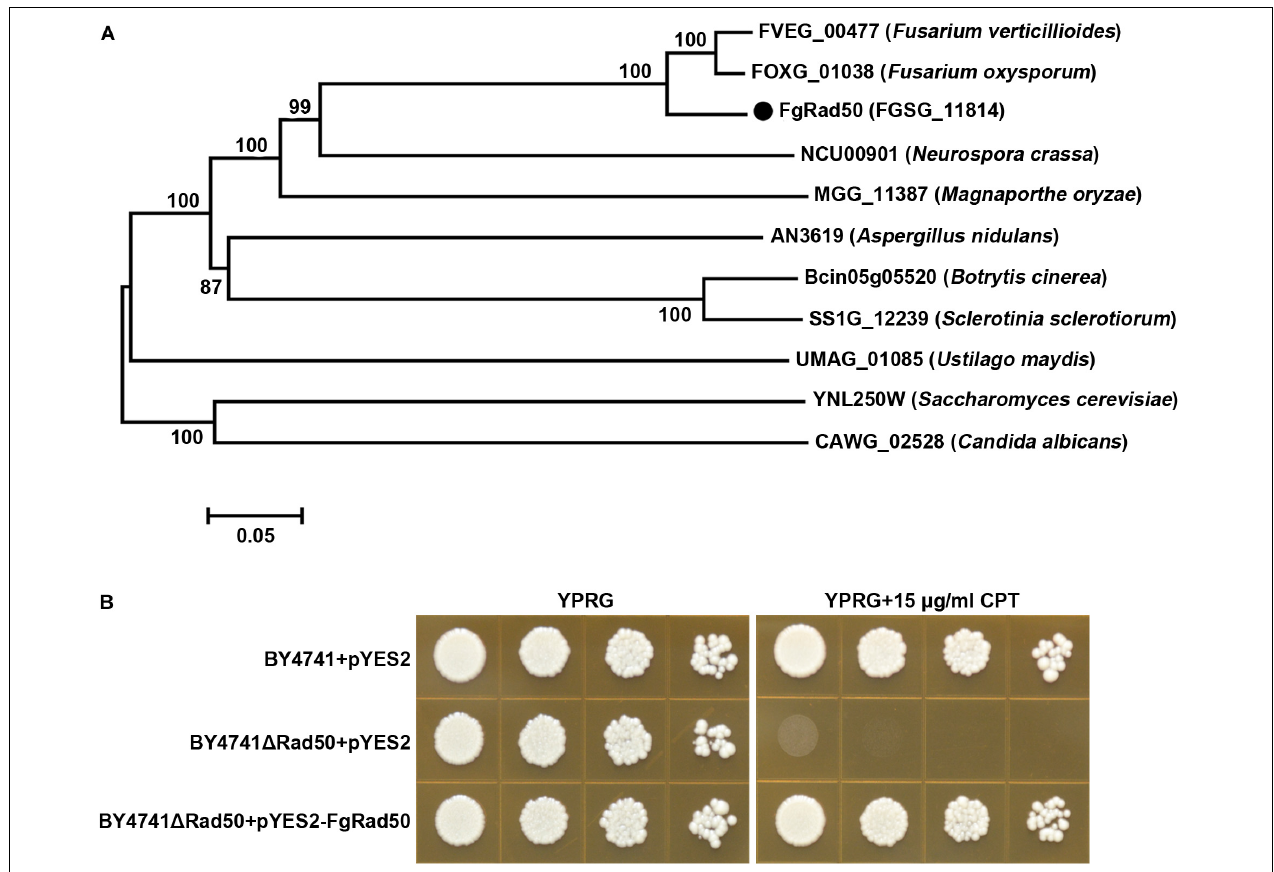
FIGURE 1 | Fusarium graminearum FgRad50 encodes a functional homolog of S. cerevisiae Rad50. (A) Phylogenetic analysis of FgRad50 with other orthologs from other fungal species. The phylogenetic tree was constructed using MEGA 5.0 with full-length protein sequences and the neighbor-joining method with 1000 bootstrap replications. Amino acid sequences are from F. graminearum (FGSG_11814 ), F. verticillioides ( FVEG_00477 ), F. oxysporum ( FOXG_01038 ), N. crassa ( NCU00901 ), M. oryzae ( MGG_11387 ), A. nidulans ( AN3619 ), B. cinerea ( Bcin05g05520 ), S. sclerotiorum ( SS1G_12239 ), Ustilago maydis ( UMAG_01085 ), C. albicans ( CAWG_02528 ), and S. cerevisia e (YNL250W). (B) FgRad50 restored the sensitivity of the yeast Rad50 mutant BY4741 (cid:49) Rad50 to the DNA-damaging agent camptothecin (CPT). The Rad50 yeast mutant was complemented with FgRad50 to generate strain BY4741 (cid:49) Rad50 + pYES2-FgRad50, which was spotted onto YPRG medium supplemented with 15 µ g/mL CPT. In addition, wild-type (WT) BY4741 and mutant BY4741 (cid:49) Rad50 strains were transformed with empty pYES2 vector and used as